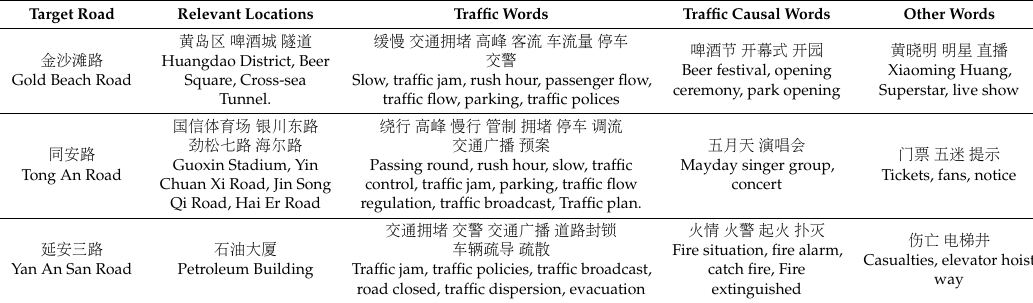
Table 7. Top 3 hottest fused traffic events in Qingdao on 4 August